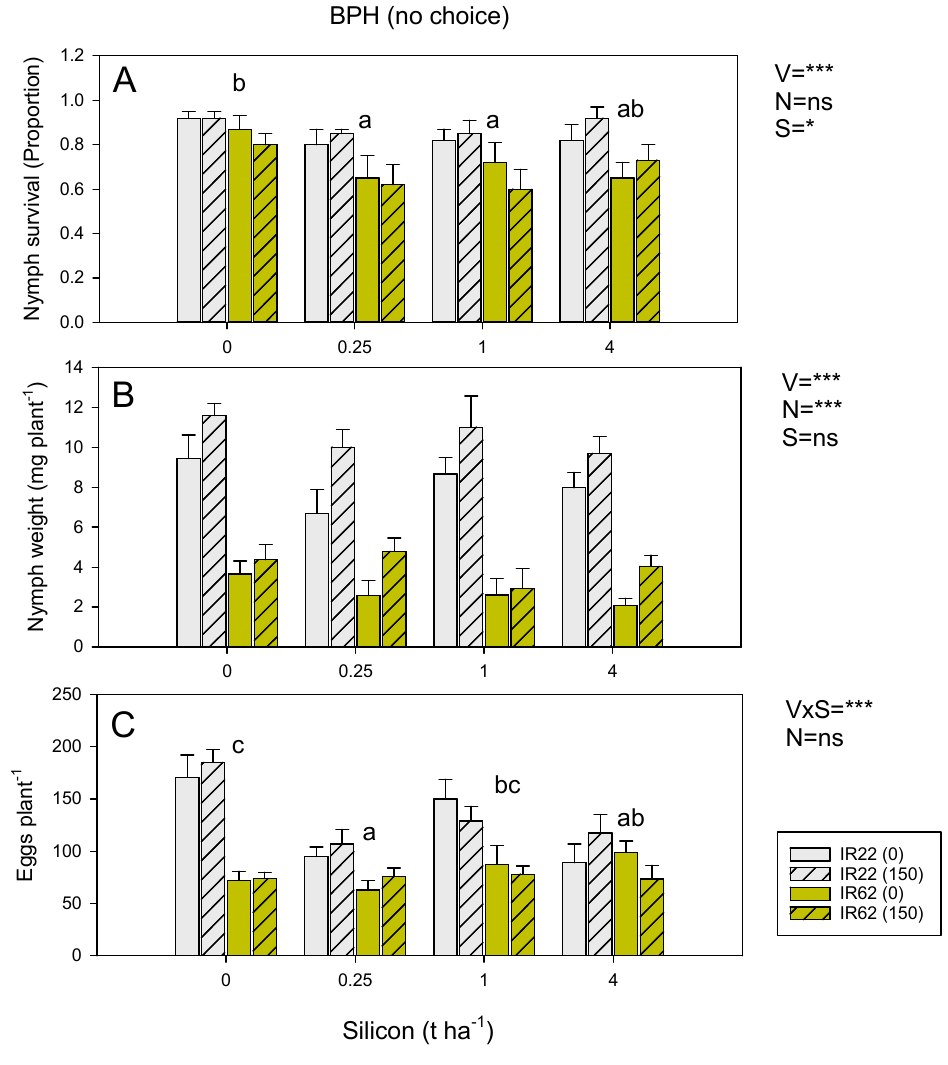
Figure 2. Effects of host resistance, soil nitrogen and soil silicon on ( A ) BPH nymph survival, ( B ) BPH nymph weight gain, and ( C ) BPH egg laying during no-choice experiments conducted in the Philippines. The experiments were conducted using IR22 (susceptible = gray bars) and IR62 (resistant = yellow bars) at 0-added (solid bars) and the equivalent of 150 Kg ha − 1 (hatched bars) added nitrogen. Soil was amended with 0, 0.25, 1 and 4 t ha − 1 equivalents of silicon. Summary statistics for univariate general linear models are indicated as V = variety, N = nitrogen level, S = silicon, V × S = variety × silicon interaction, ns = p > 0.05, * = p ≤ 0.05, and *** = p ≤ 0.001. Standard errors are indicated (sample size = 6); lowercase letters indicate homogenous silicon groups. See also Table S2.